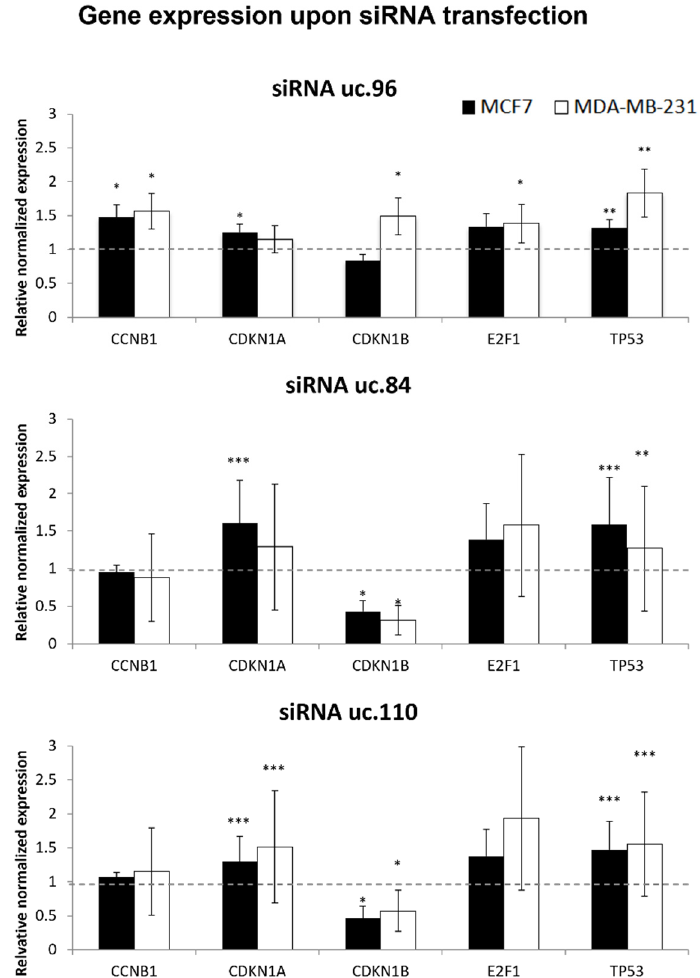
Figure 5. Quantitative analysis of miR-221 targets and cell cycle genes upon T-UCR siRNA transfection. Quantification by RT-qPCR demonstrated modulation of gene expression after treatment, calculated with respect to mock transfections. The dashed line parallel to the X axis indicates control relative expression of 1. Histograms represent the means of 8 independent experiments ± SEM. Statistical significance was determined by unpaired two tailed Student’s t -test; p -value < 0.05 (*), p -value < 0.01 (**), p -value < 0.001 (***).